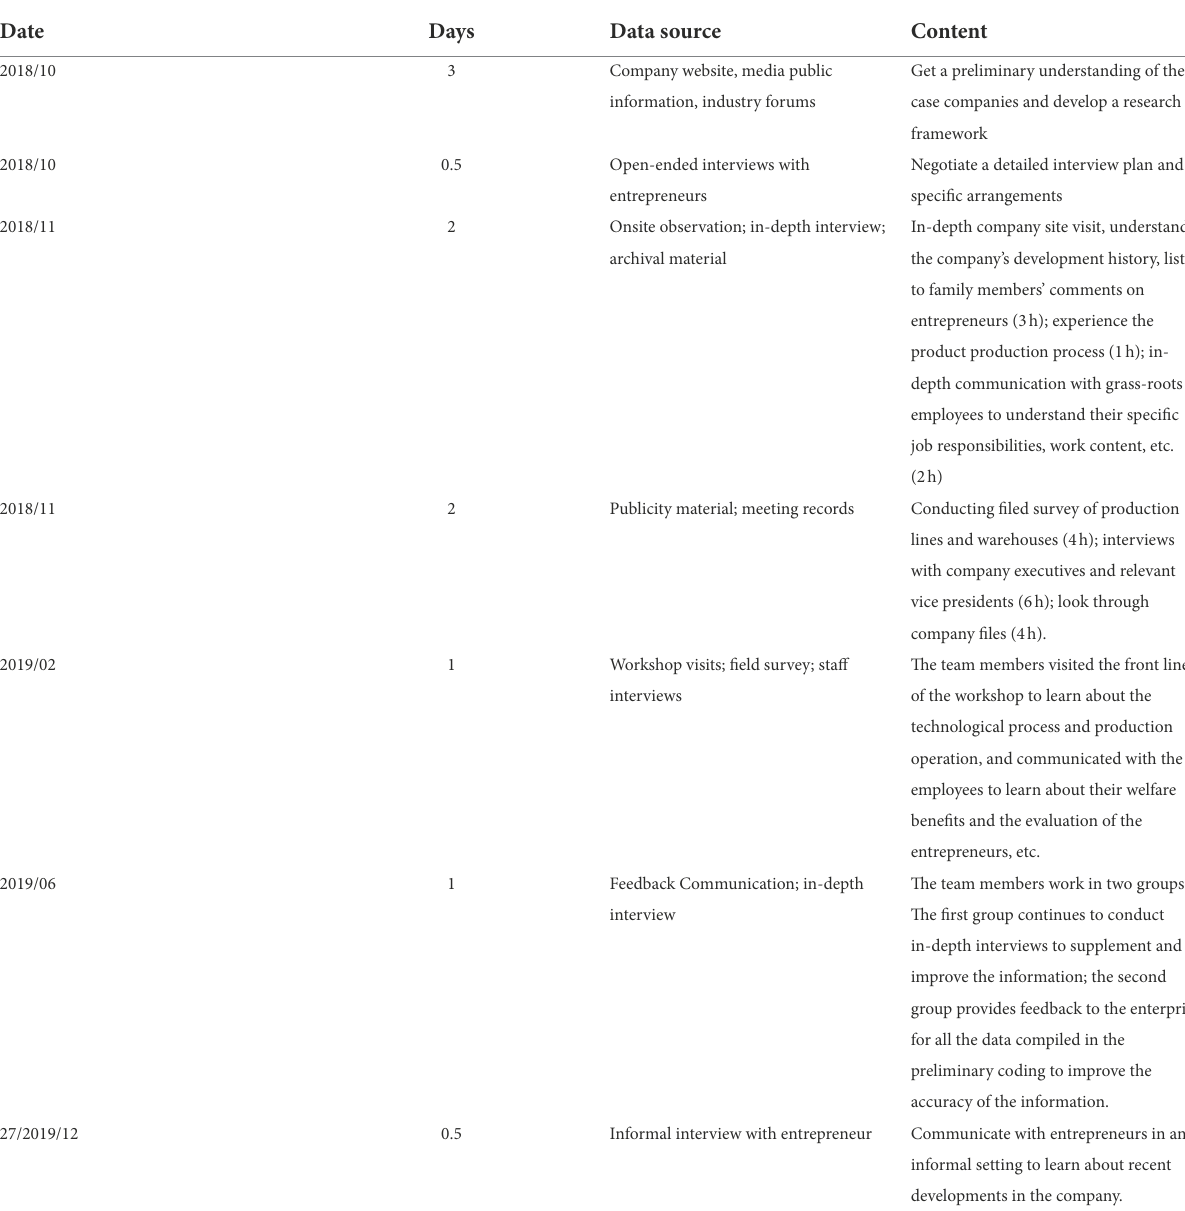
TABLE 1 Summary of data